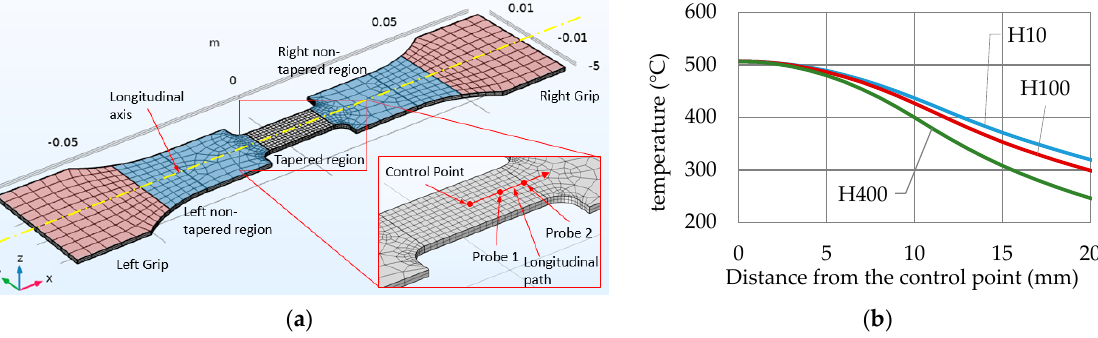
Figure 12. ( a ) Geometry of tapered specimens in the FE model; ( b ) Peak temperature profile simulated with different heat transfer coefficients.